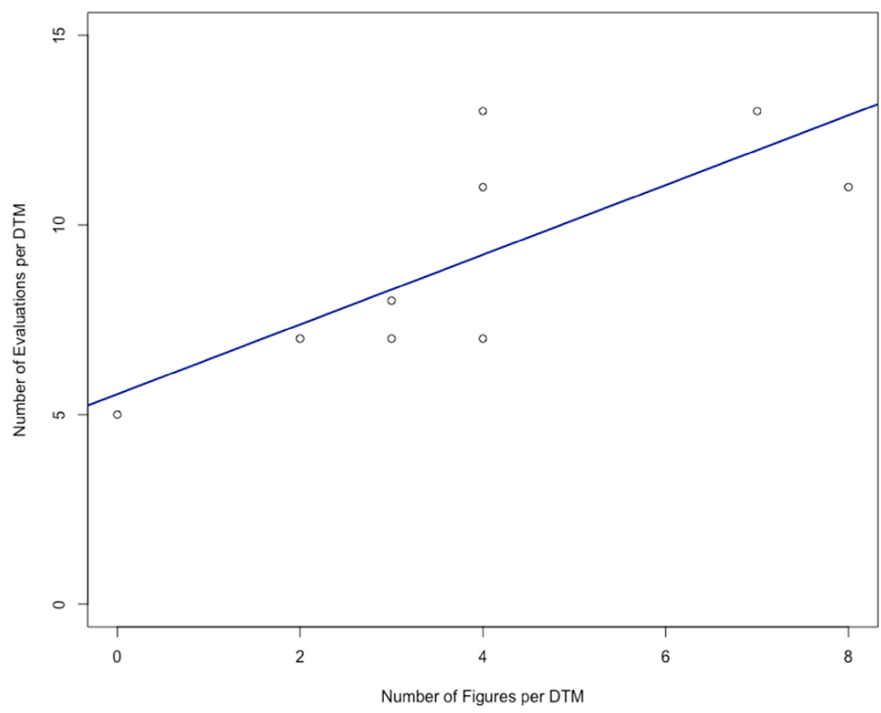
Figure 2. Number of figures per digital teaching module (DTM) and average number of evaluations of the respective module.